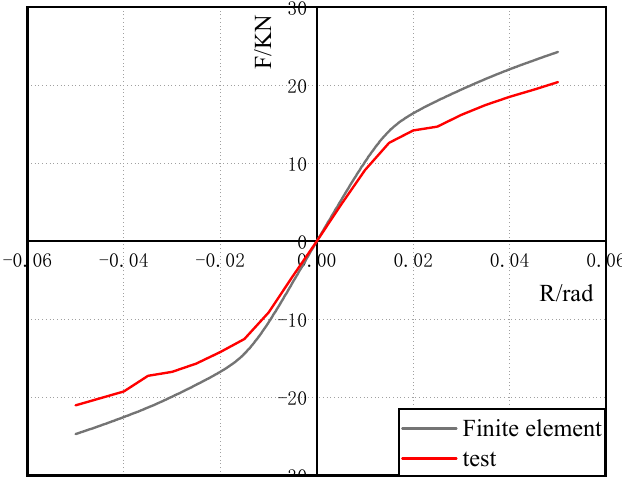
Figure 15. Skeleton curve comparison.